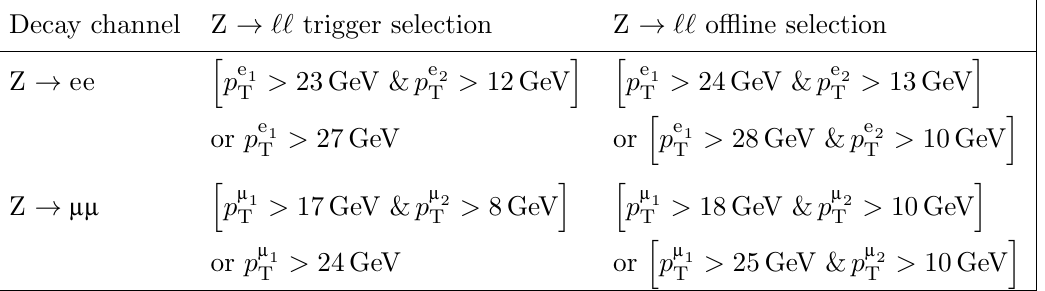
Table 1 . Trigger and o(cid:15)ine selection requirements for the di(cid:11)erent Z boson decay modes. The events are selected using either dilepton triggers with lower- p gers with higher- p thresholds. The subscripts 1 and 2 indicate the higher- and lower- p T associated with the Z boson,